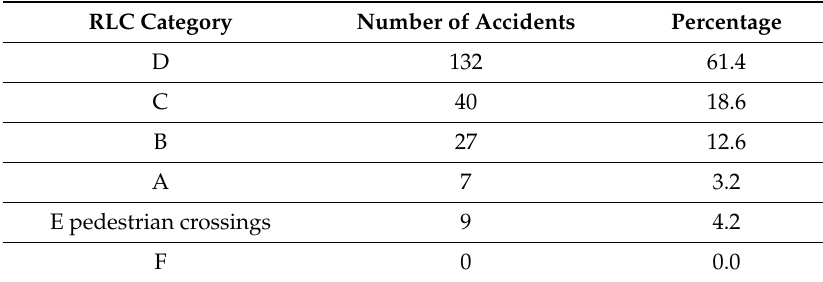
Figure 6. Percentage share of the number of railway level crossings and transitions, accidents, and fatalities, particularly RLC categories and transitions, in the Polish railway network. Table 3. RLCs with accidents.